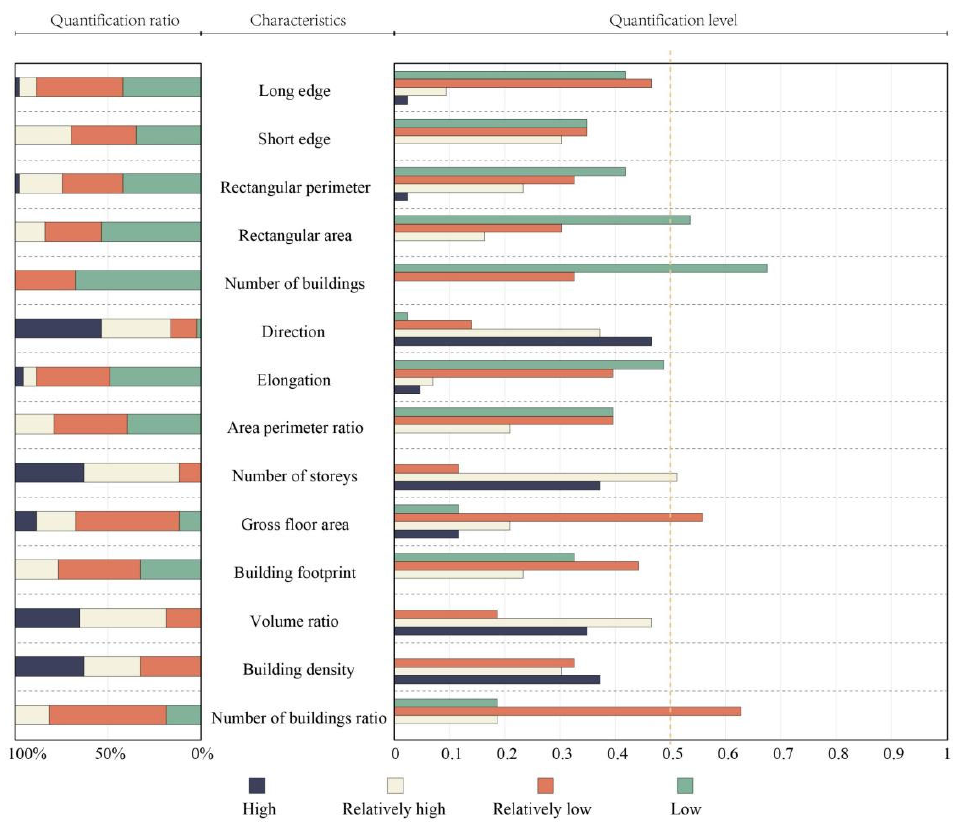
Figure 11. Quantitative identification class of major characteristics for category 4.